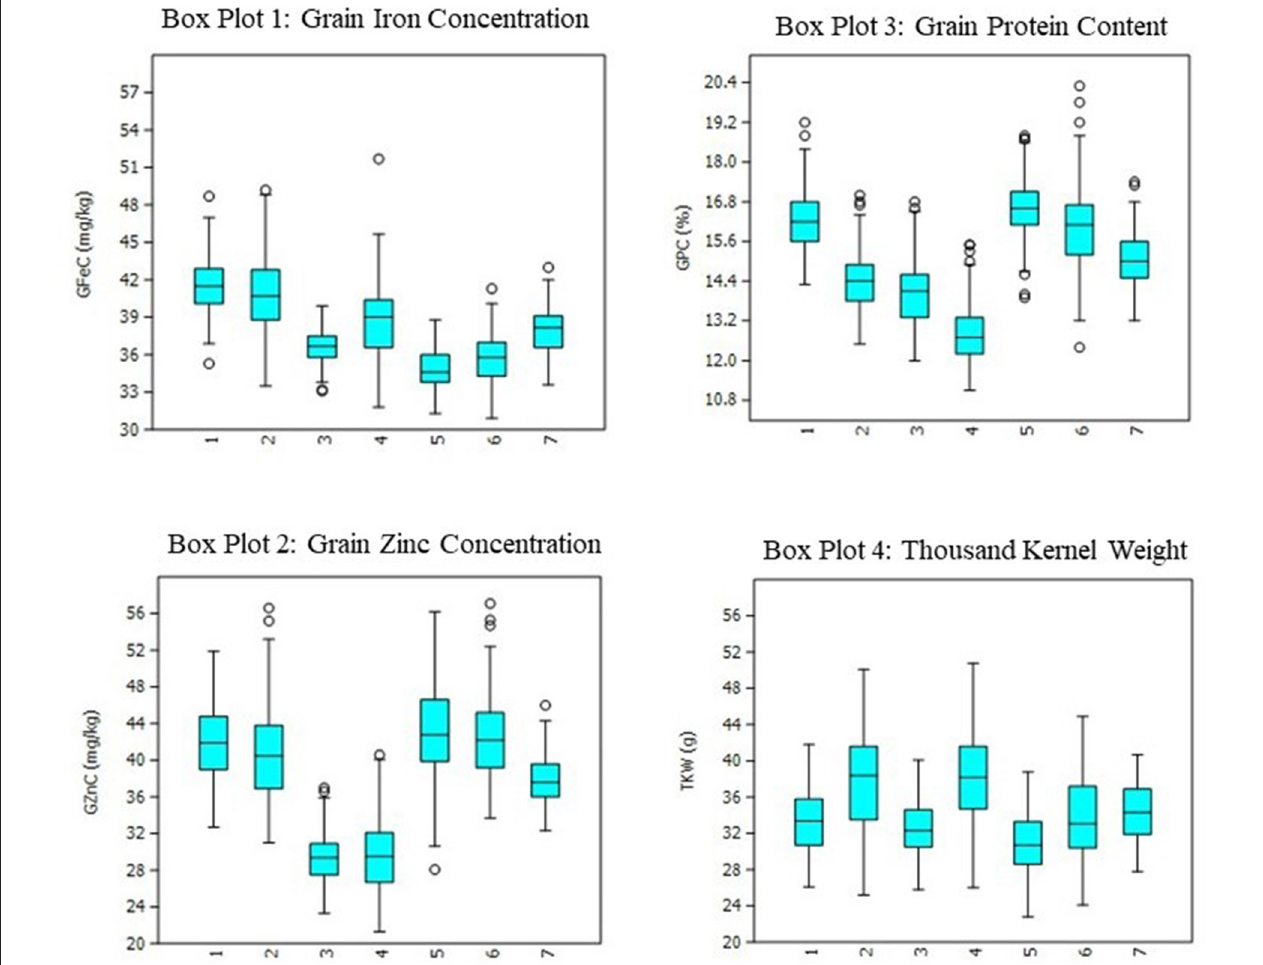
FIGURE 1 | Boxplots for grain iron, zinc, protein, and thousand kernel weight in RIL population grown across three locations for 2 years. 1: ICAR-IARI_Y1; 2: ICAR-IARI_Y2; 3: GBPUA&T_Y1; 4: GBPUA&T_Y2: 5: Pusa Bihar_Y1; 6: Pusa Bihar_Y2; 7: Pooled mean.